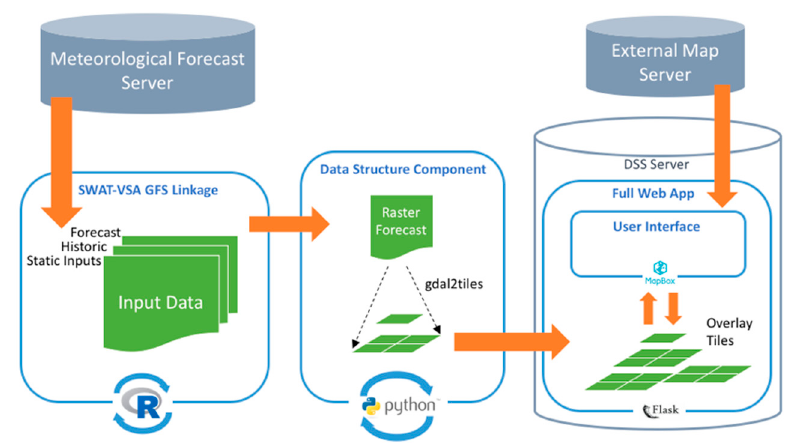
Figure 1. Overview of the DSS including the Global Forecast System weather forecast (GFS–MOS), the model (SWAT–VSA GFS linkage) component, the data structure component, and the user interface.